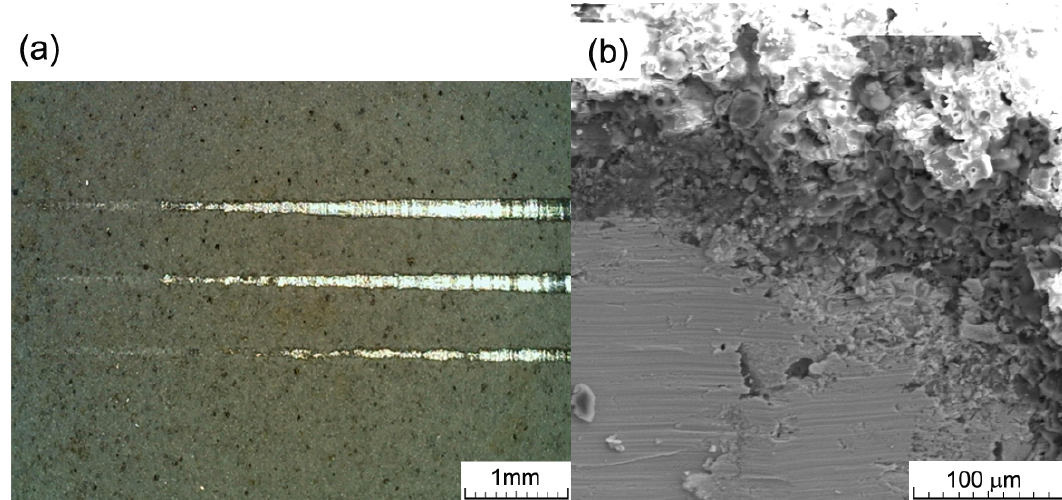
Figure 8. OM and SEM images of scratch marks: ( a ) OM, ( b ) SEM detail of the ceramic layer.